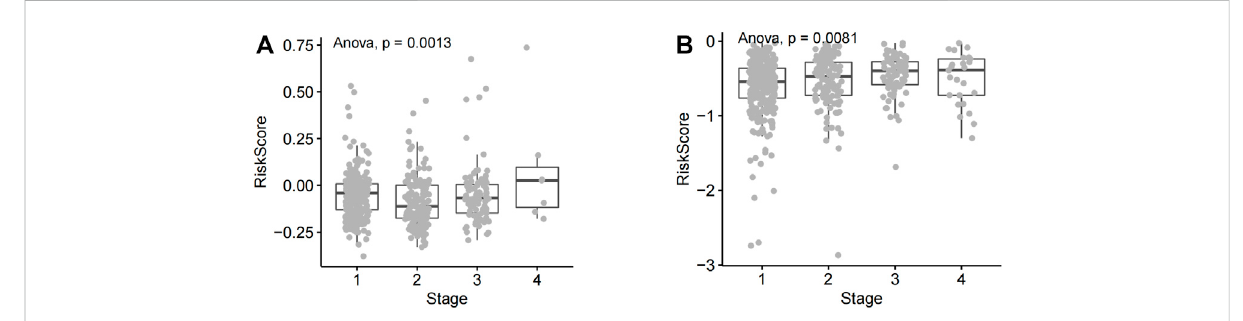
FIGURE 5 Correlation between riskscore and different TNM stages of non-small cell lung cancer. (A) A comparative analysis of risk scores in LUSC T staging. (B) A comparative analysis of risk scores in LUSC N staging. (C) A comparative analysis of risk scores in LUSC M staging. (D) A comparative analysisofriskscoresinLUADTstaging (E) AcomparativeanalysisofriskscoresinLUADNstaging. (F) AcomparativeanalysisofriskscoresinLUADM